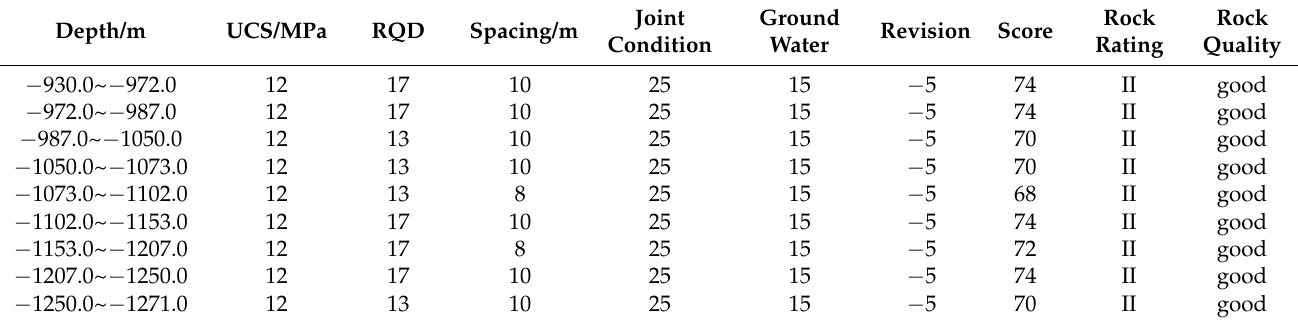
Table 5. Classification results of rock mass quality based on RMR.